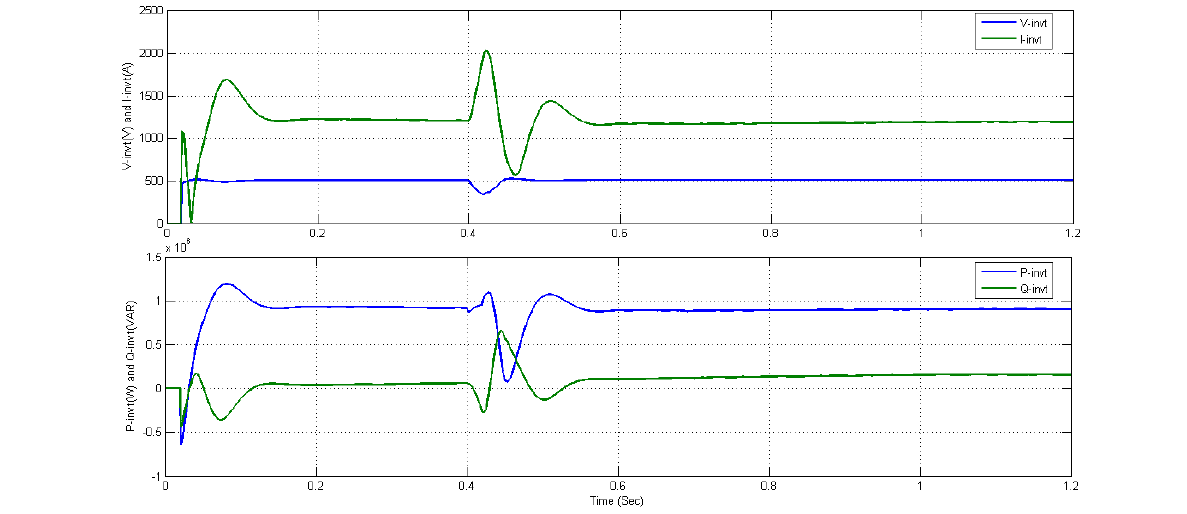
Figure 14 . Inverter performance under grid